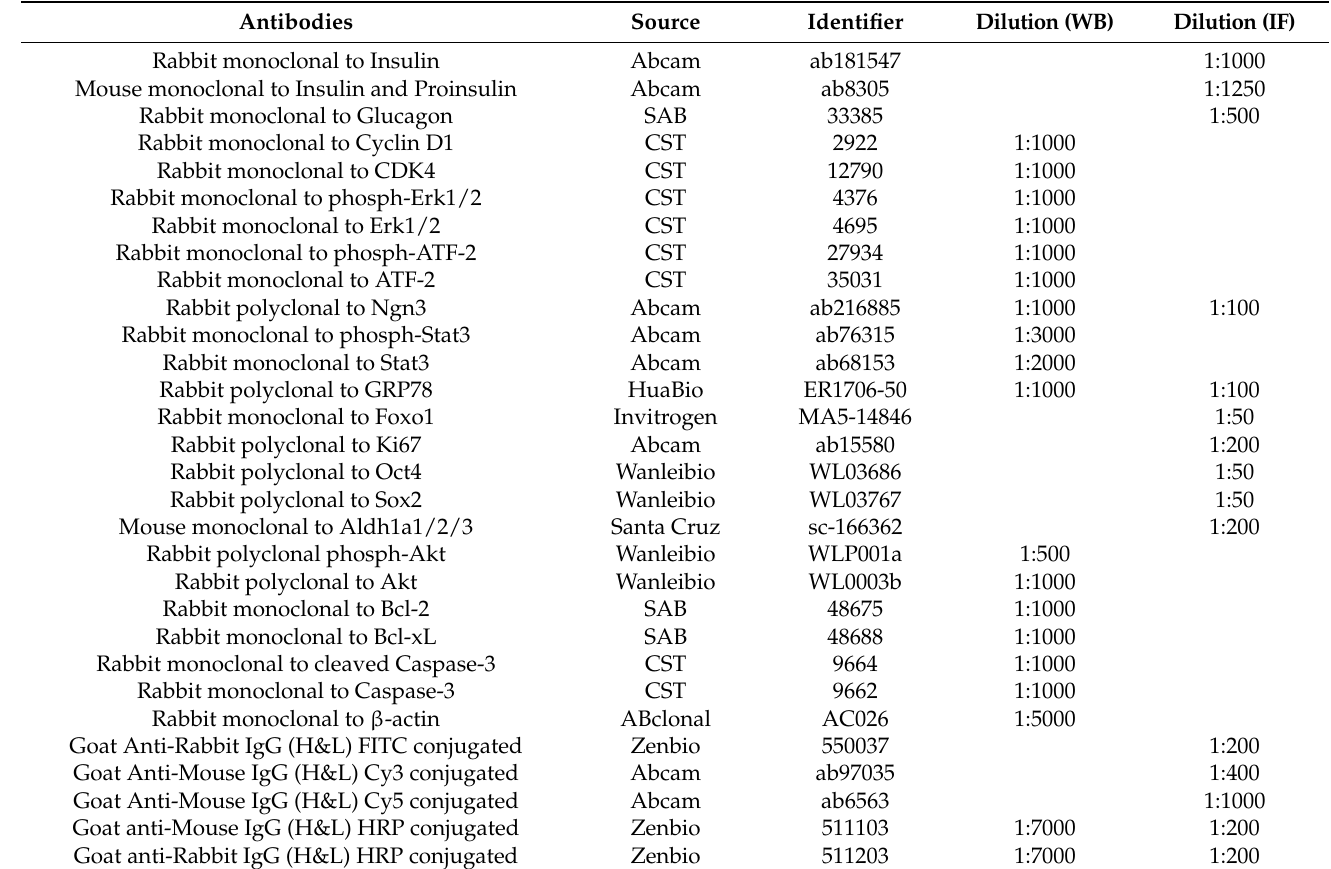
Table 1. Antibodies used in Western blotting and histological